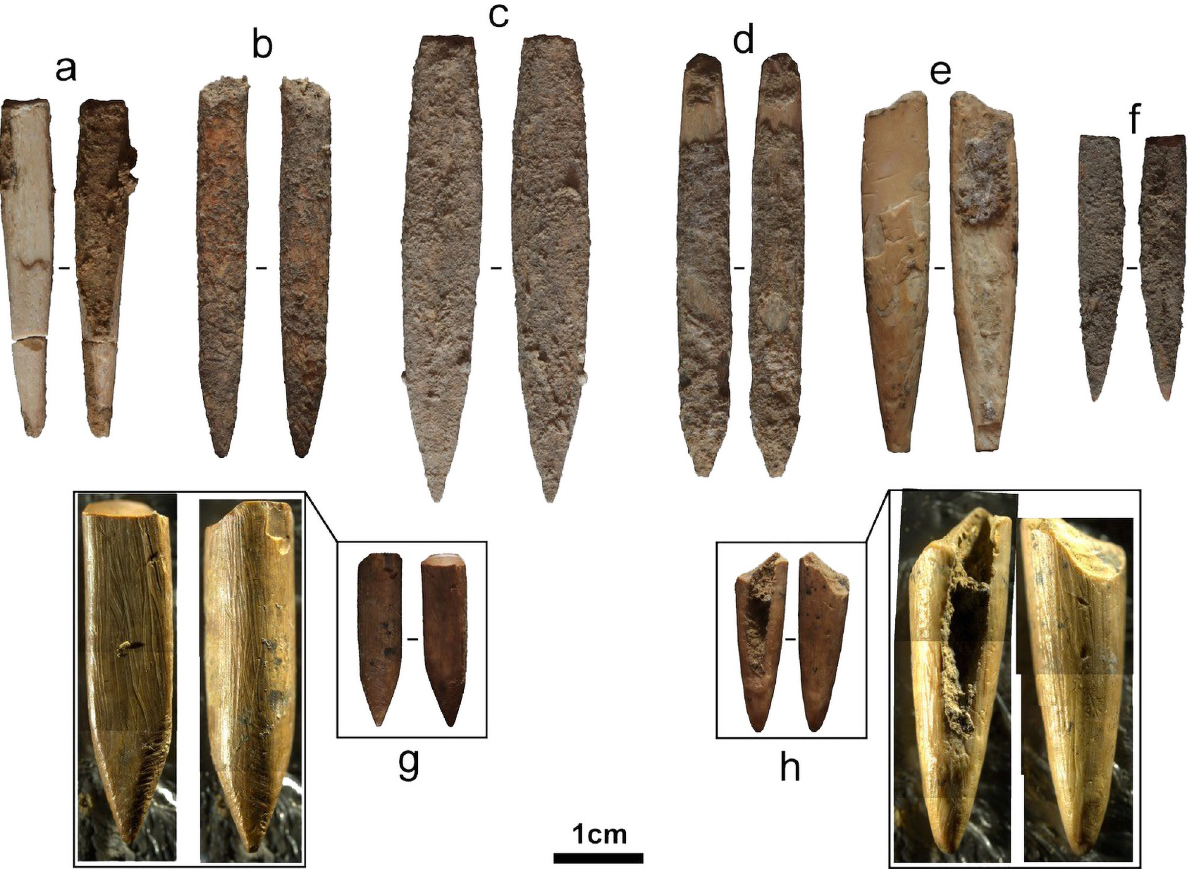
Fig 19. Osseous points. Pointed osseous artefacts from Leang Pajae and Leang Bulu’ Sipong 1 made on suid teeth.